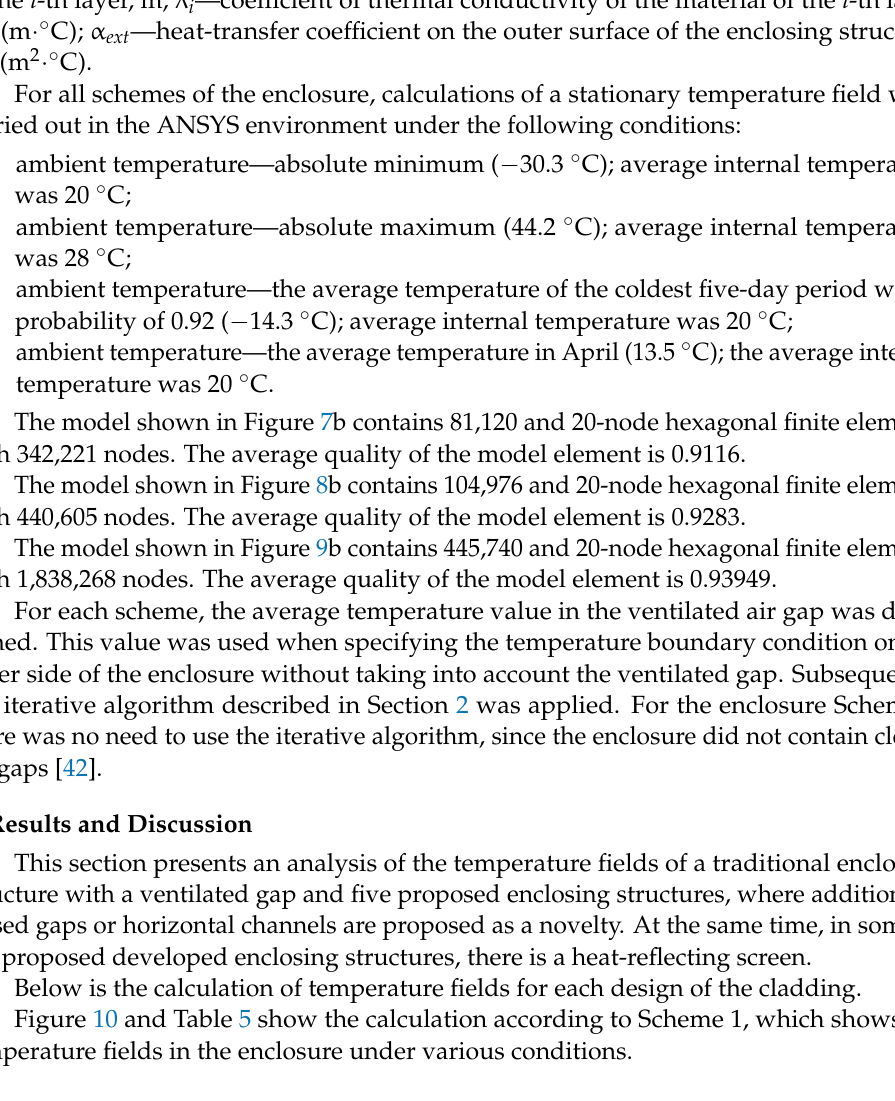
Table 5. Thermal resistance of the enclosure according to Figure